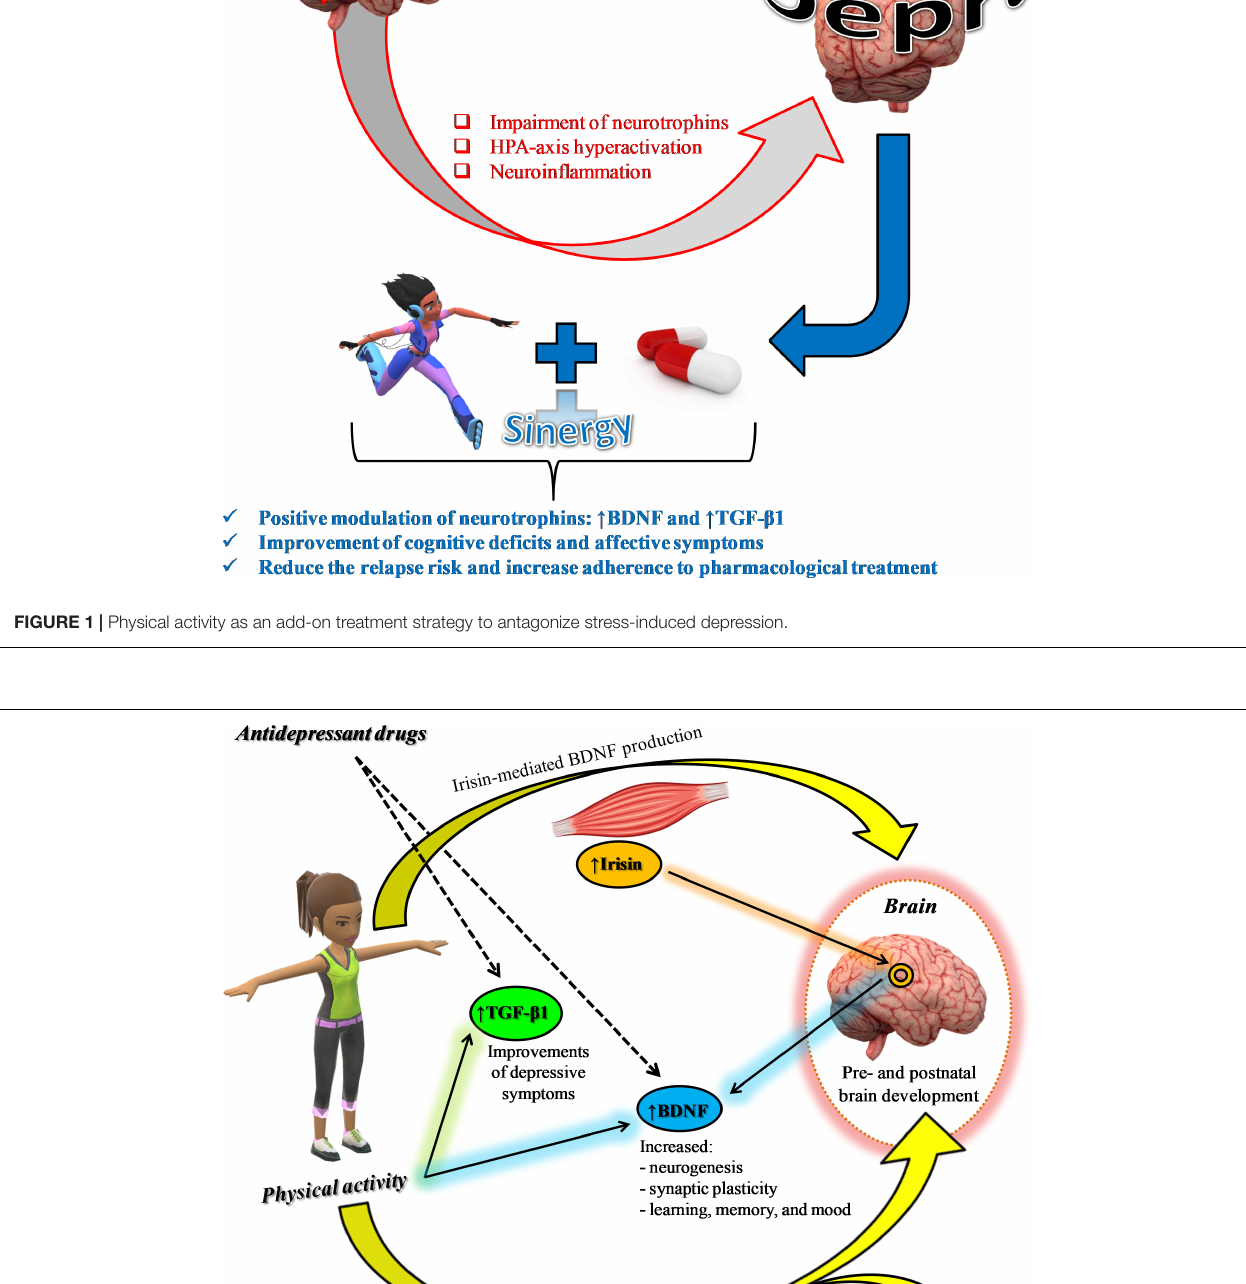
Frontiers in Psychology |